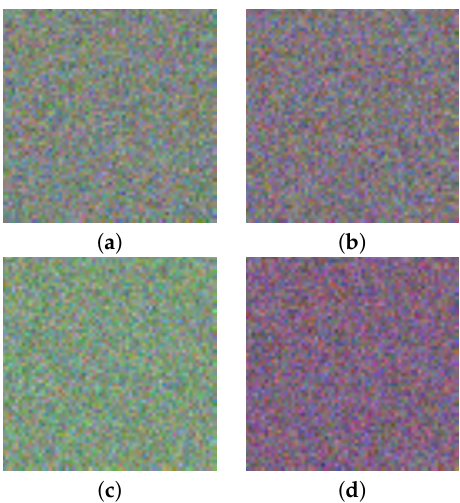
Figure 10. Synthetic 64 × 64 pixels images: ( a , b ) with µ difference in channel G equal to one standard deviation for classes 1 and 2; ( c , d ) with µ difference in channel G equals to three standard deviations for Classes 1 and 2. Source: prepared by the